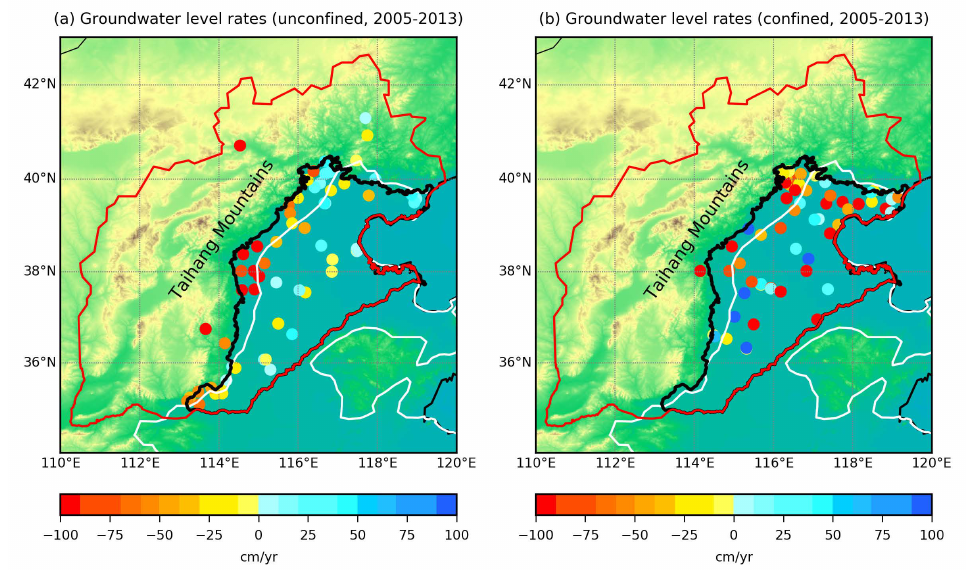
Figure 4. Groundwater level rates based on ground monitoring wells from ( a ) unconfined and ( b ) confined aquifers in the North China during